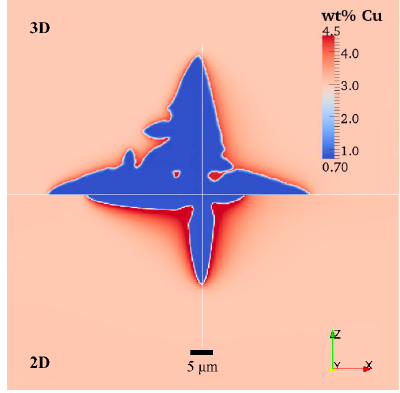
Figure 8. Solute distribution around 2D (lower) and 3D (upper) dendrites.